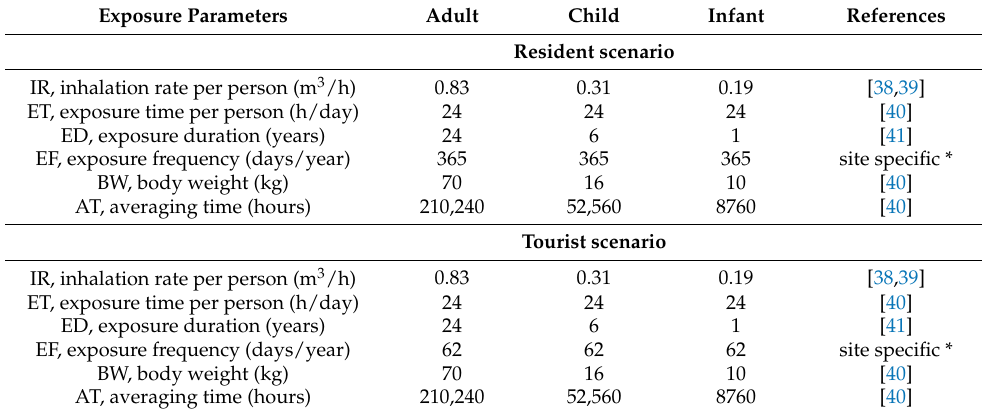
Table 1. Exposure parameters used for the risk assessment calculations in the